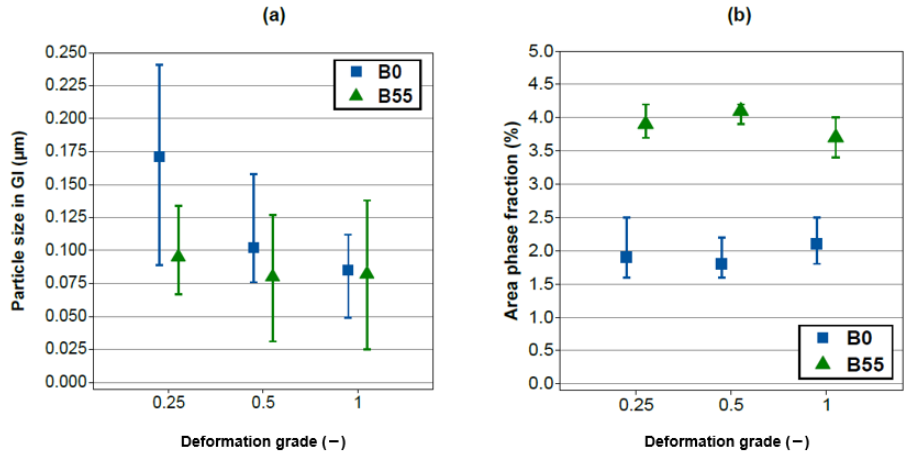
Figure 5. Quantitative particle analysis results: ( a ) mean particle size in the grain interior (GI) and ( b ) area phase fraction after thermomechanical treatment of the reference B0 and the boron-alloyed B55 steel with deformation grades from 0.25 to 1 at an 800 °C deformation temperature.